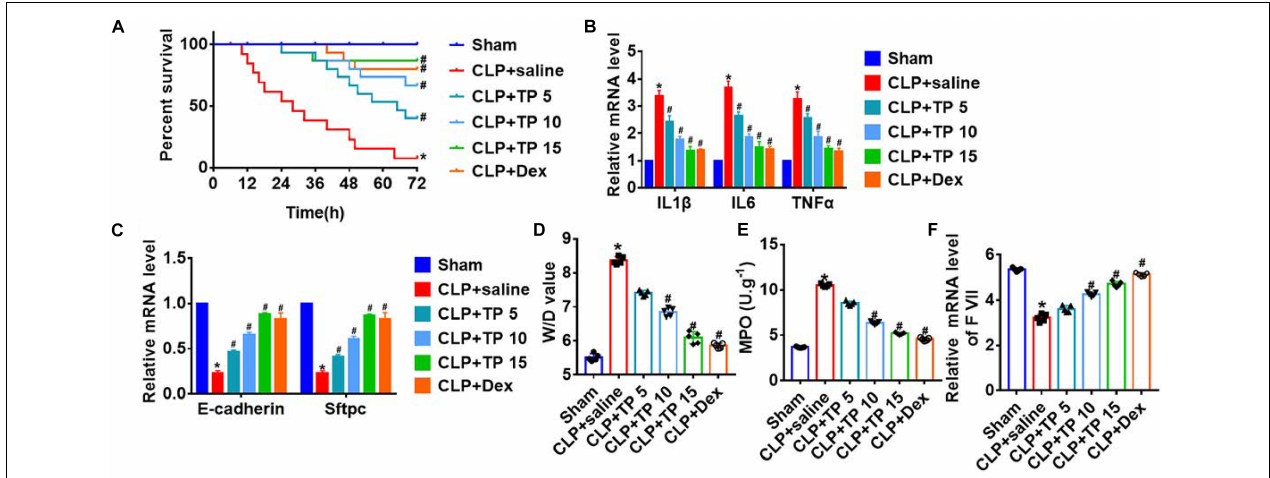
FIGURE 1 | CLP increased survival and improved pulmonary epithelial function in response to CLP operation. Rats were suffered from CLP or sham surgery with or without TP (5, 10, and 15 mg/kg) and saline (24 ml/kg): Sham ( n = 15), CLP (CLP model with saline injection, n = 15), CLP + TP 5 (CLP model with 5 mg/kg TP injection, n = 15), CLP + TP 10 (CLP model with 10 mg/kg TP injection, n = 15), CLP + TP 15 (CLP model with 15 mg/kg TP injection, n = 15). And, dexamethasone (2 mg/kg) served as a positive control. (A) Survival plots for rats in different groups. * P < 0.05 vs. Sham, # P < 0.05 vs. CLP. (B) H&E staining for lung sections. (C) The mRNA expression of inflammatory factors (IL1 β , IL6, and TNF α ). n = 4; * P < 0.05 vs. Sham, # P < 0.05 vs. CLP. (D) Quantitative RT-PCR was performed to analyze the mRNA expression of E-cadherin (Cdh1) and Sftpc. n = 5, * P < 0.05 vs. Sham, # P < 0.05 vs. CLP. (E) Wet dry mass ratio (W/D) of lungs was calculated. n = 5, * P < 0.05 vs. Sham, # P < 0.05 vs. CLP. (F) Myeloperoxidase (MPO) of lungs was examined. n = 5, * P < 0.05 vs. Sham, # P < 0.05 vs. CLP. The mRNA level of F VII was detected using qRT-PCR. n = 5, * P < 0.05 vs. Sham, # P < 0.05 vs.